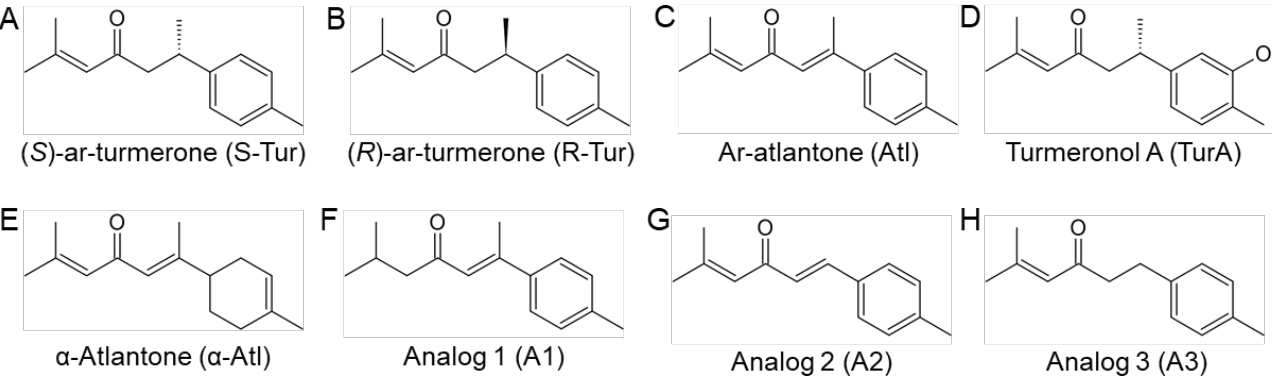
Figure 1. Chemical structures of ar-turmerone analogs. ( A – H ) Chemical structures of (S)-ar-turmerone ( A ), (R)-ar-turmerone ( B ), ar-atlantone ( C ), turmeronol A ( D ), α -atlantone ( E ), analog 1 ( F ), analog 2 ( G ), and analog 3 ( H ).